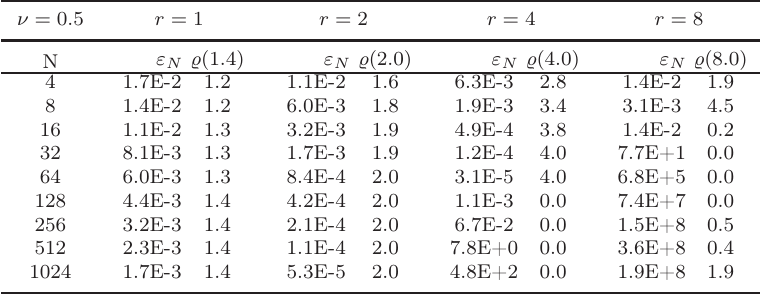
Table 1. Numerical results, “exact” system